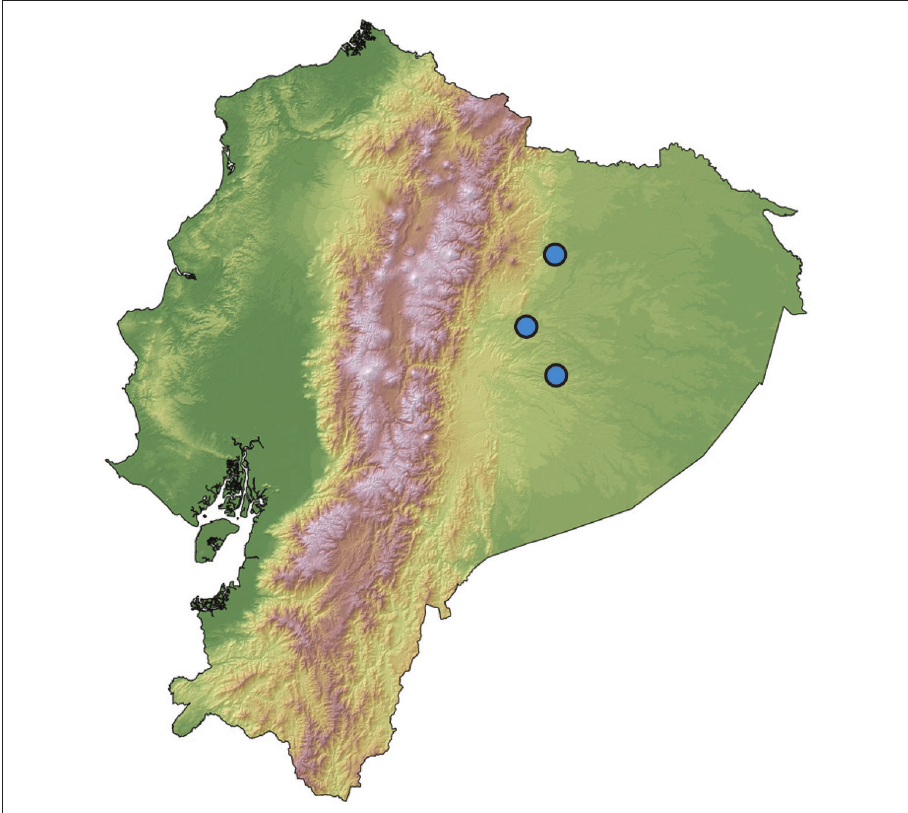
Figure 6. Distribution of Hyalinobatrachium yaku in